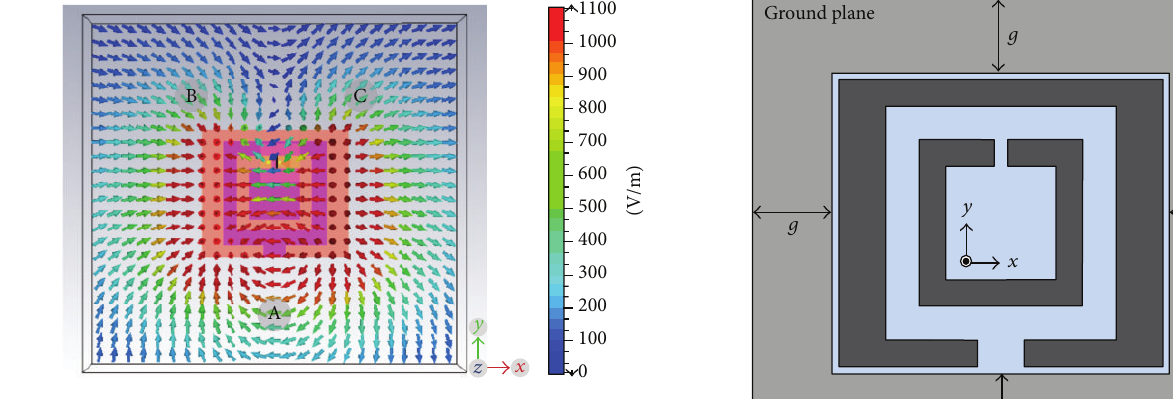
Figure 10: Electric field distribution in the 𝑥 - 𝑦 plane at a distance of 7 mm above the surface of the upper substrate at 𝜔𝑡 = 90 ∘ .